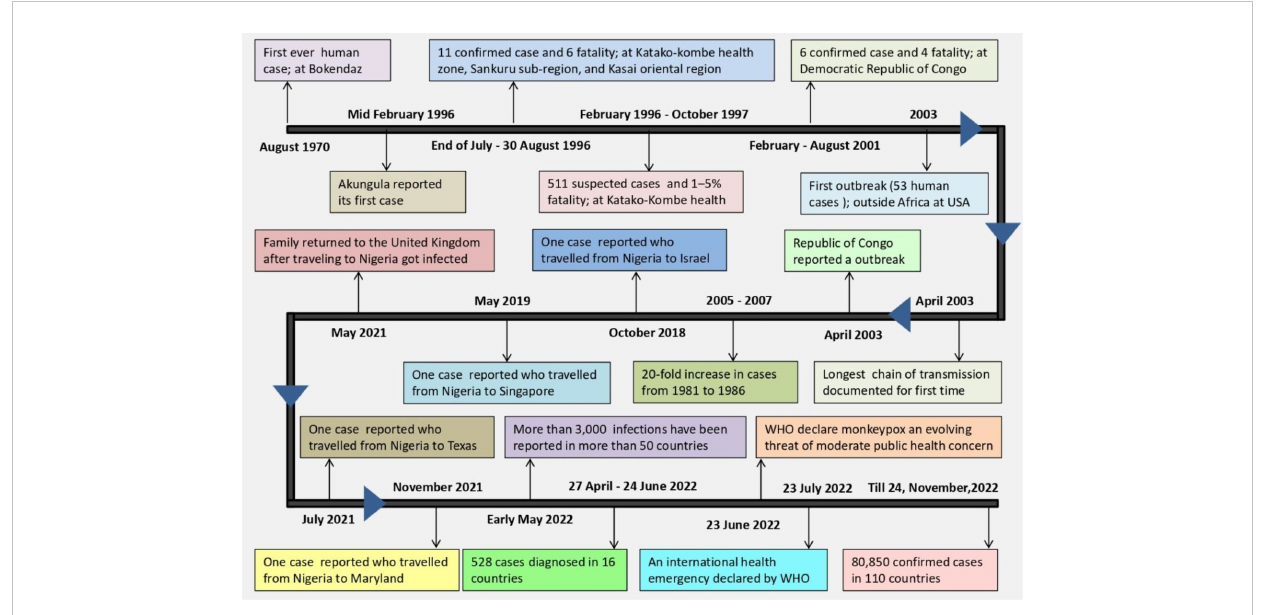
FIGURE 2 Timeline of events in monkeypox ’ s global